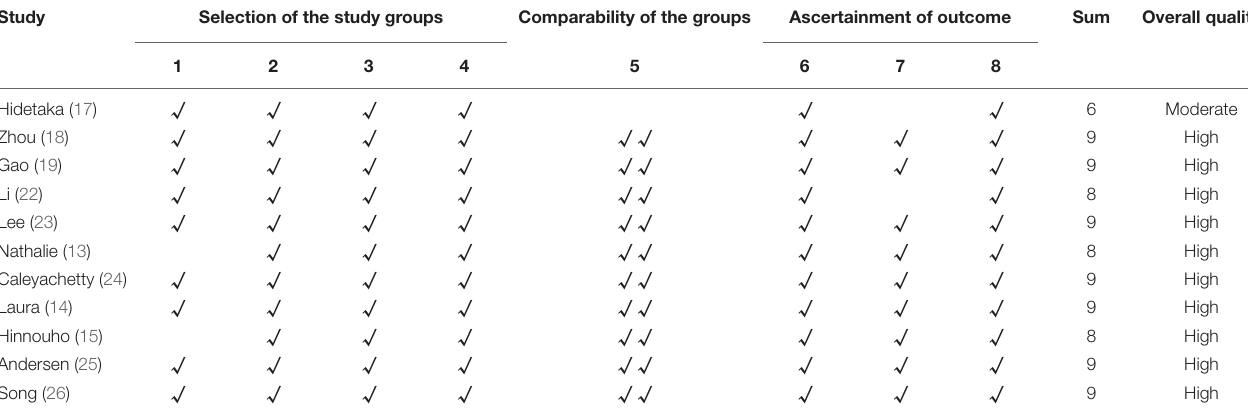
TABLE 2 | Quality evaluation of the included studies.